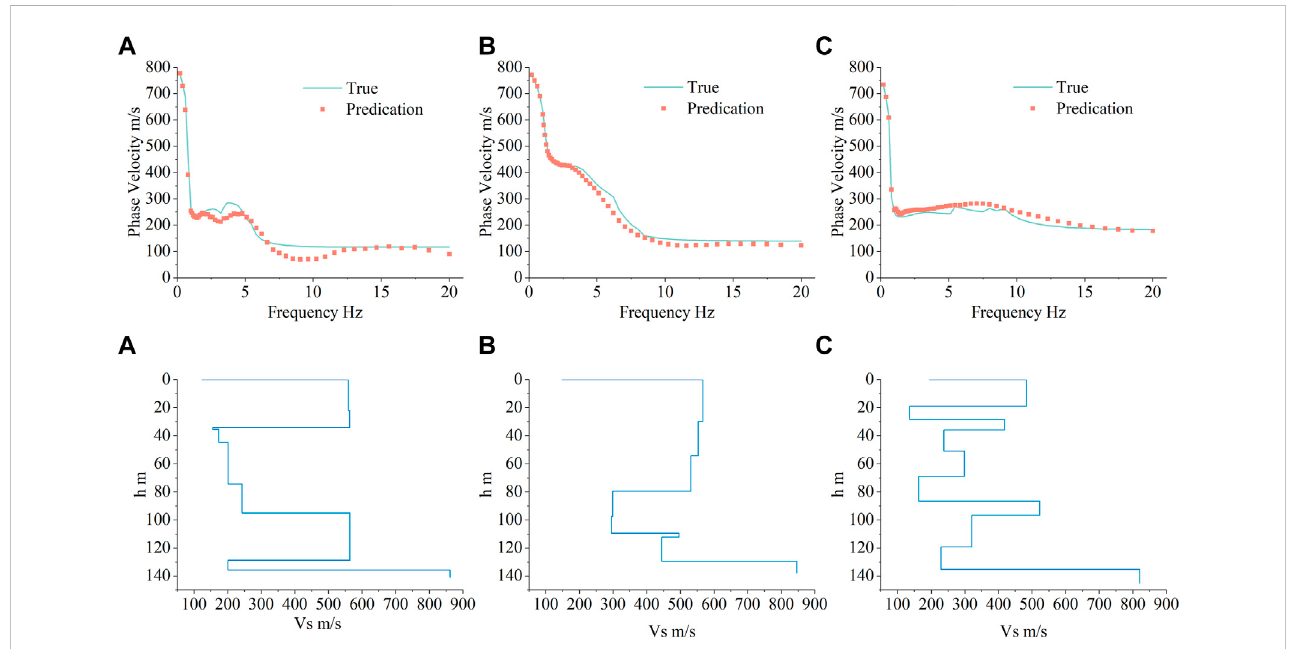
FIGURE 10 Phase velocity dispersion curve prediction graph and velocity structure graph.